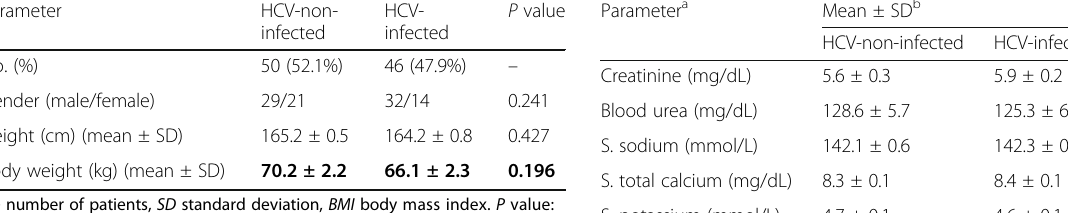
Table 1 Baseline data for included HCV-non-infected and HCV- Table 3 Comparison of renal function parameter between HCV- infected haemodialysis patients non-infected and HCV-infected haemodialysis patients Parameter HCV-non- HCV- infected infected